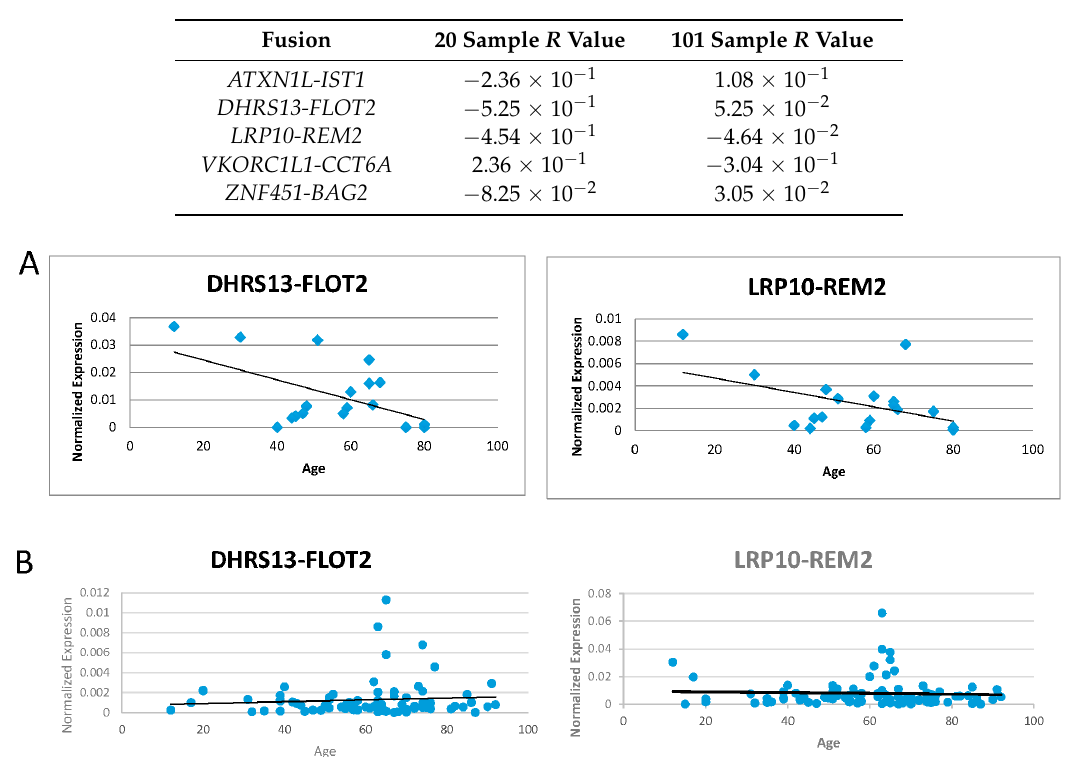
Table 2. Summary of R -values of normalized expression levels correlated with age for confirmed fusions at the 20 sample and 101 sample level.